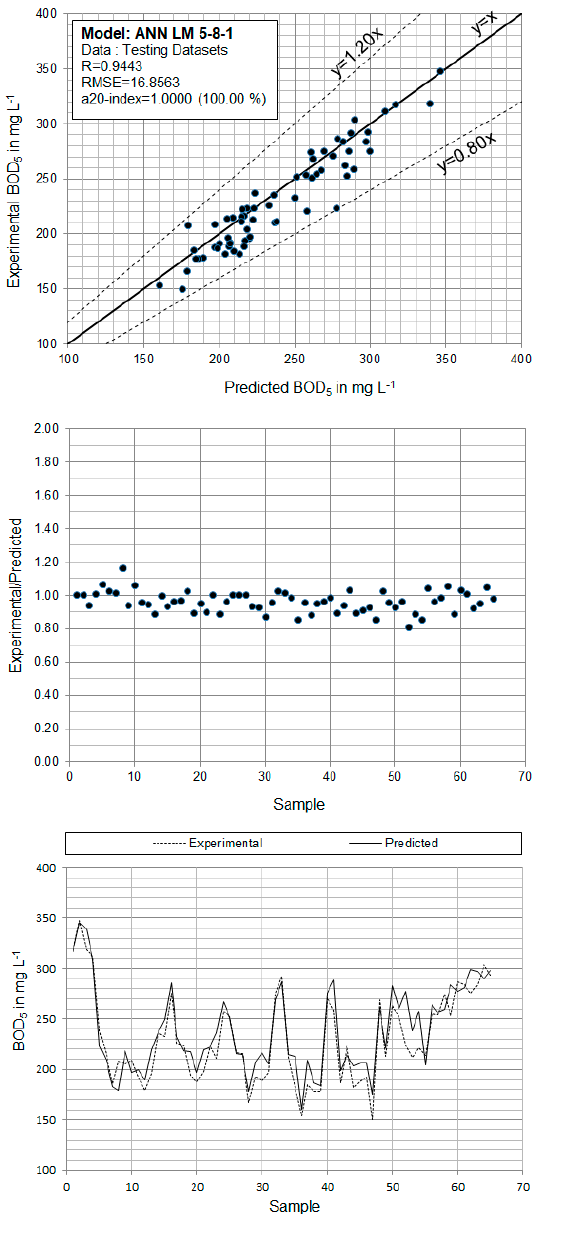
Figure 6. Experimental vs. predicted values of the five-day biochemical oxygen demand (BOD 5 ) in wastewater for training and testing datasets, using the developed ANN LM 5-8-1 model.